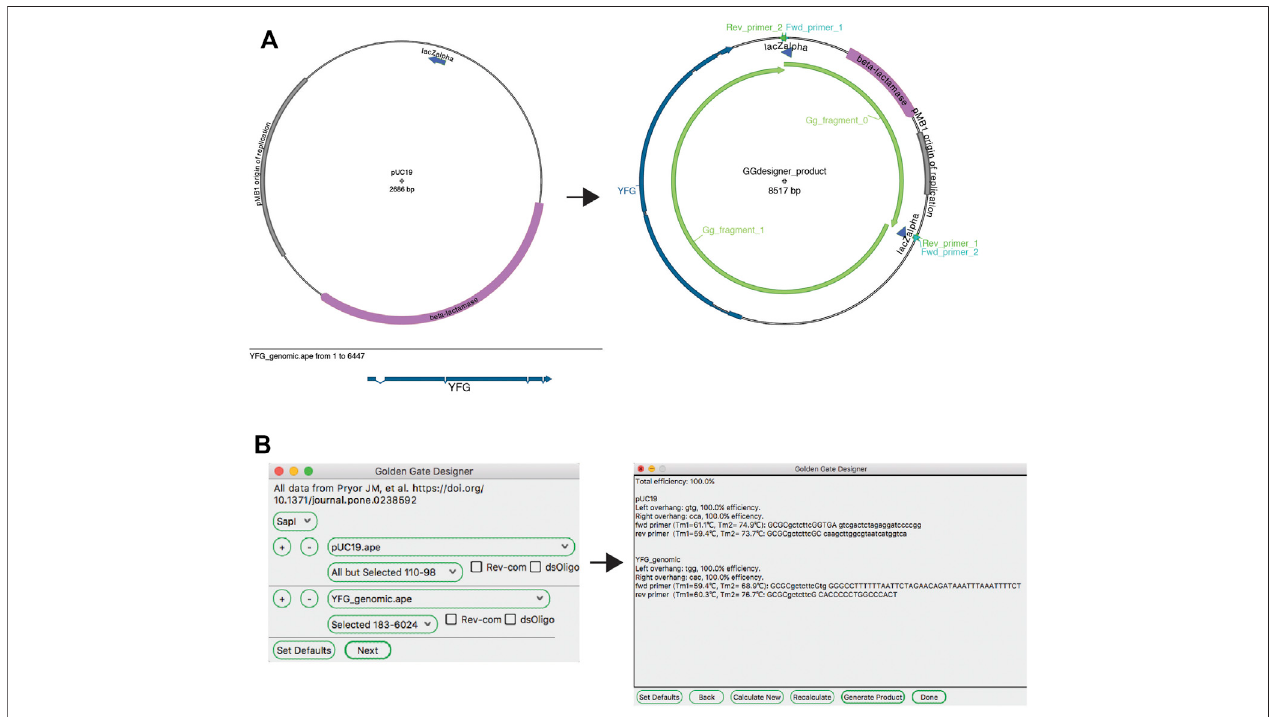
FIGURE 6 | The Golden Gate Assembler tool. (A) A graphic map of two SapI restriction fragments as designed in Figure 5 to be used in a Golden Gate reaction (left),andtheproductofthereaction(right). (B) TheGoldenGateAssemblershowsthechosenSapIrestrictionenzyme,theselectedinputfragmentsandthethree-base overhangs of each SapI cut.